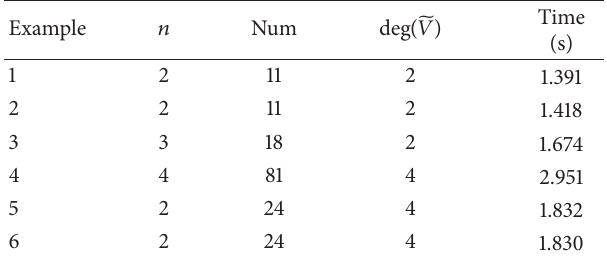
Table 1: Algorithm performance on benchmarks (globally asymp- totic stability).